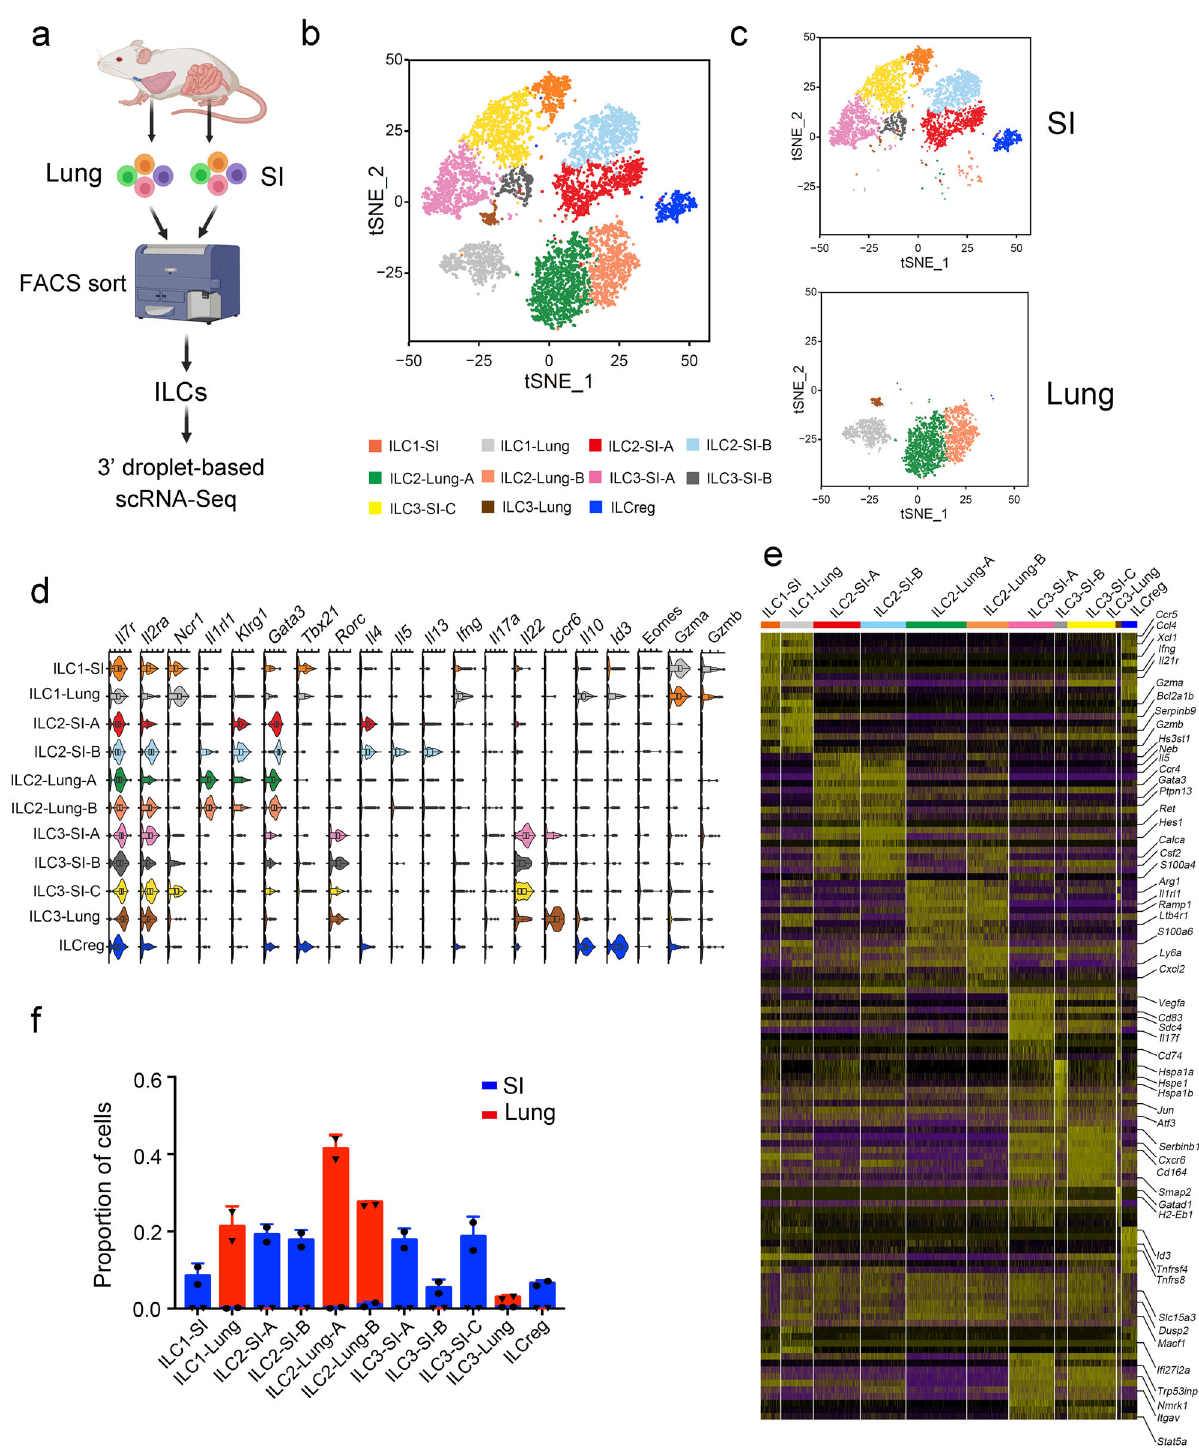
Fig. 1 | Heterogeneity of ILCs in the lung and small intestine. a Experimental designforscRNAsequencingofILCsinthelungandsmallintestine.Weisolatedthe ILCs(Lin - CD45 + CD127 + )fromthelungandsmallintestine(SI)ofwildtype(WT)mice (Lin=CD3e,CD8a,CD19,CD11b,CD11c,Gr1,F4/80,Ter119) by fl ow cytometry. Isolated ILCs were subjected to 3 ’ droplet-based scRNA sequencing. The mice share the similar distribution of ILCs from the same tissue and we pooled them together as one sample for scRNA-seq ( n =5 for each sample). Two biological repetitions were made for each sample. The schematic diagram was created with BioRender.com. b ILC subsets were determined and shown by t-Distributed stochastic neighbor embedding (tSNE). Low quality cells and contaminates were removed. Eleven ILC